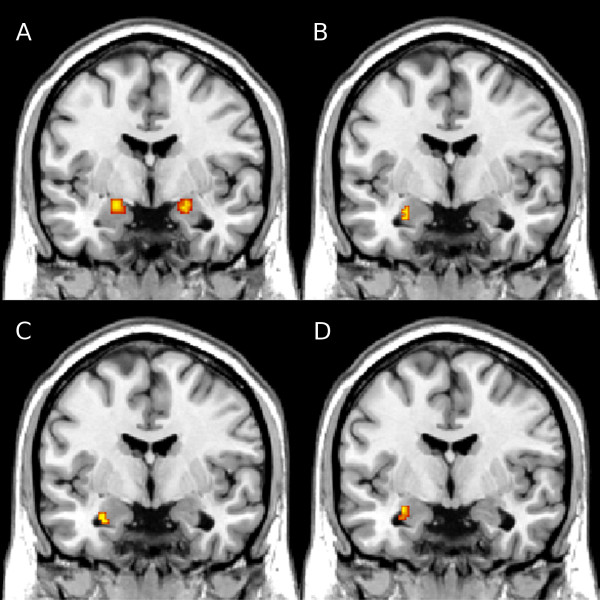
The cluster results observed in the amygdalae, overlaid on an
anatomical template. The figures present the observed
responses to the negative stimuli (A), the observed
correlation between the response to the negative stimuli and HA
(B) and between the response to the positive stimuli and
HA (C) as well as the observed main effect of group
(D).